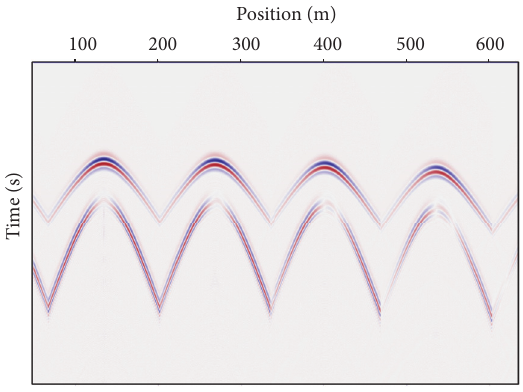
Figure 7: The synthetic traces from the single-point